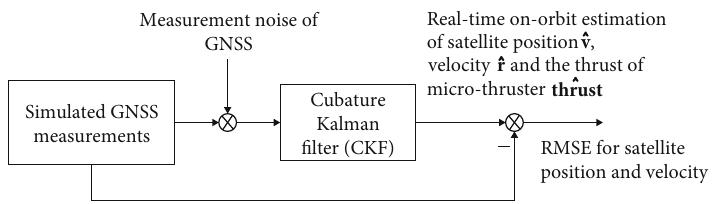
Figure 3: The speci fi c simulation process.